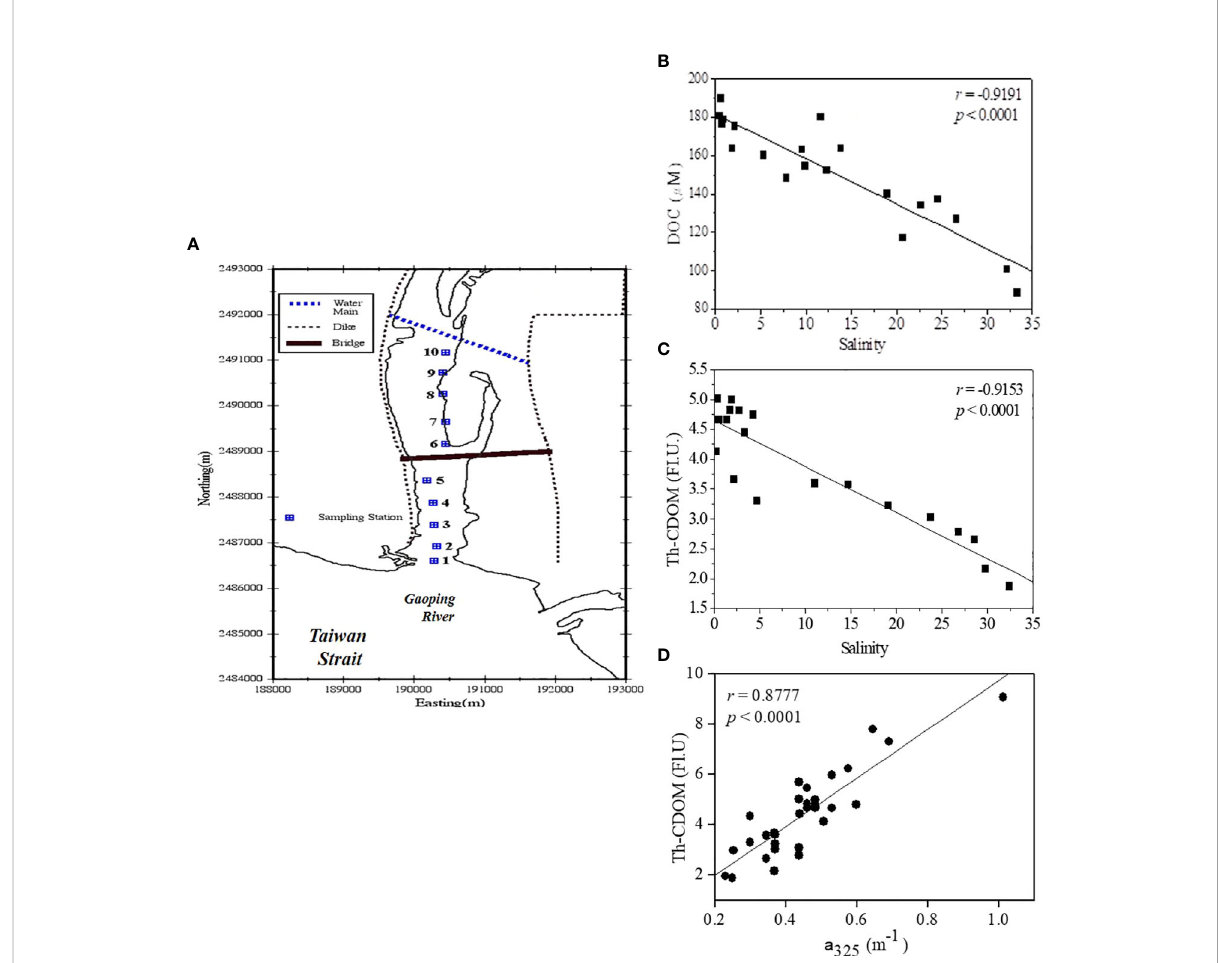
FIGURE 8 Sampling locations (A) and conservative mixing evidences of DOC (B) and Th-like CDOM [ (C) , EX/EM: 320 − 360 nm/420 − 460 nm] in the Gaoping Estuary (Taiwan). The correlation is highly signi fi cant between CDOM absorption coef fi cient values and CDOM (Th-CDOM) fl uorescence intensity (D) in the